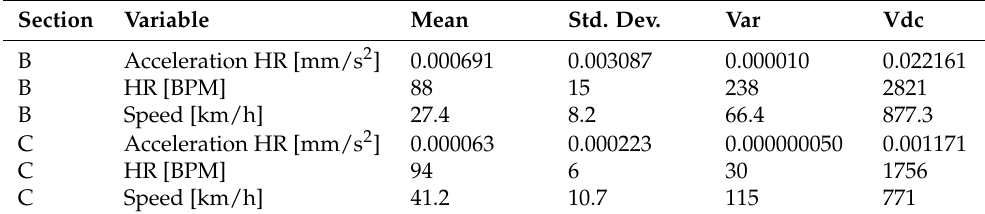
Table 7. Statistical parameters for sections “B” and “C”.